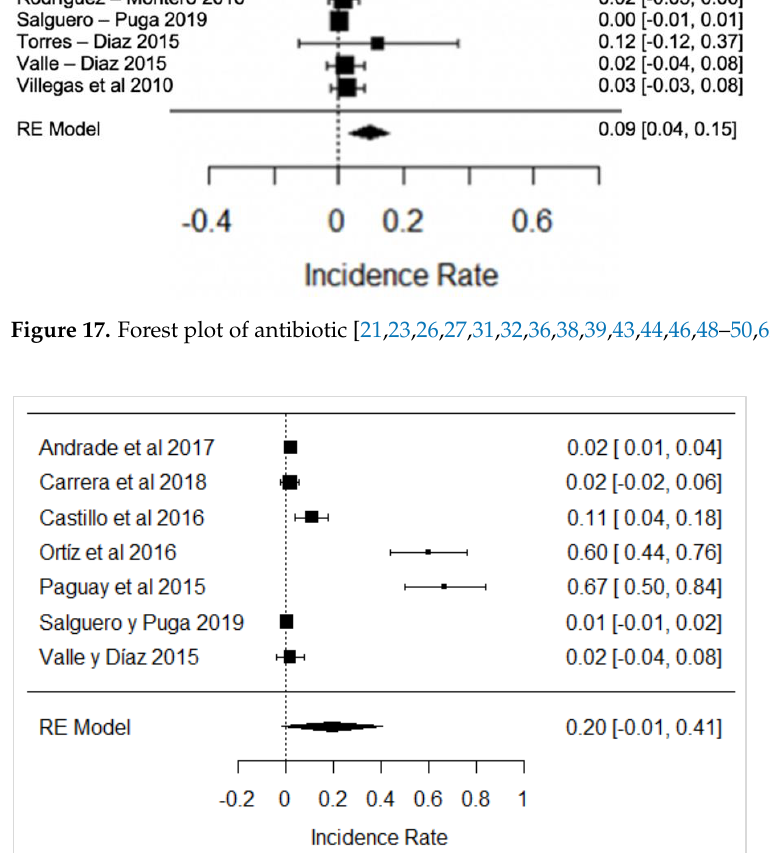
Figure 18. Forest plot of neutralizing agents [21,31,32,39,43,44,82].